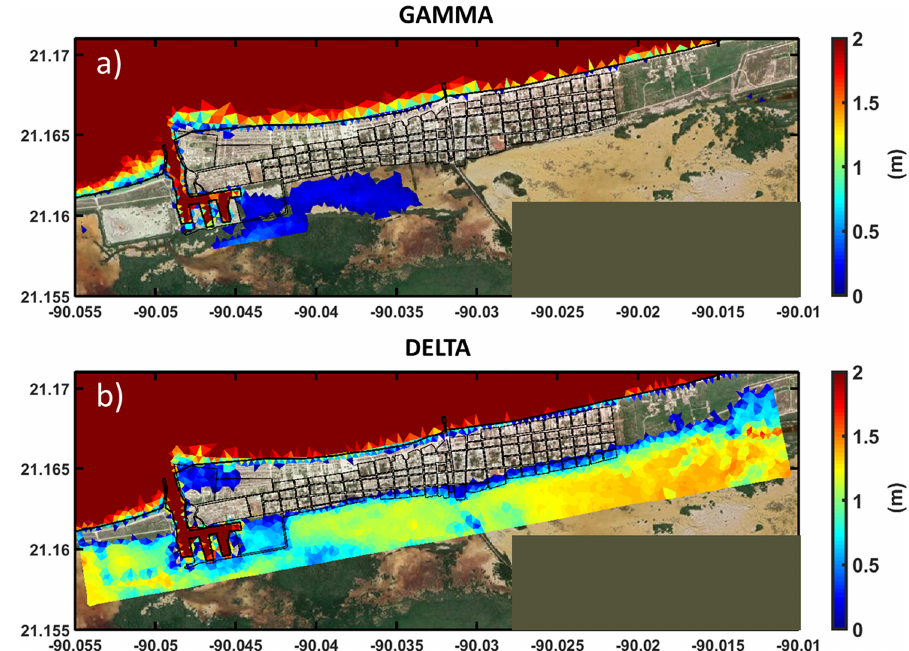
Figure 14. Maximum envelopes for the storm surge generated by events (a) Gamma and (b) Delta at Sisal, Yucatán.